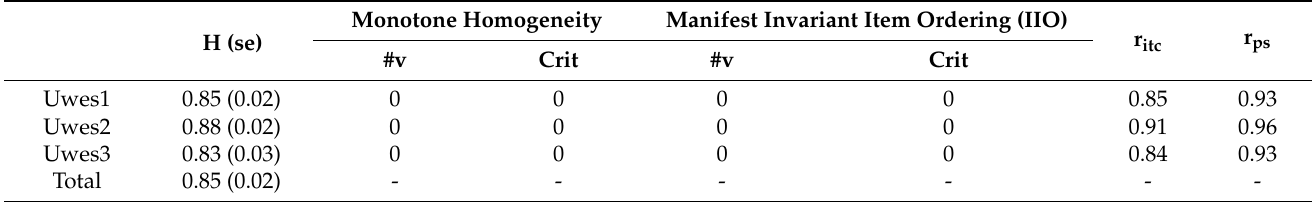
Table 2. Nonparametric modelling: Mokken scale analysis for the UWES-3.